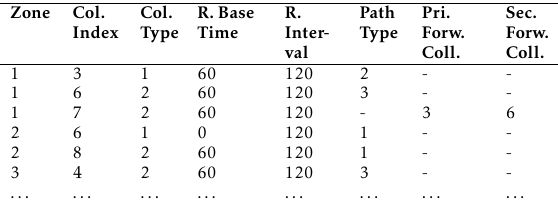
Table 5. Output: Collectors’ Configurations Zone Col. Col. R.Base Index Type Time